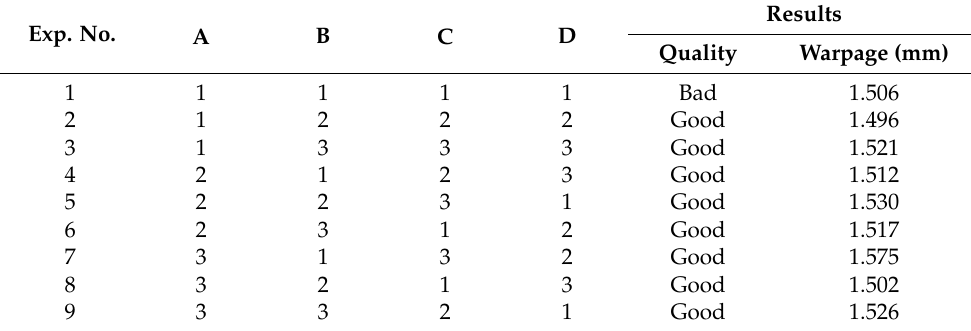
Table 5. Quality and warpage results of the simulation.